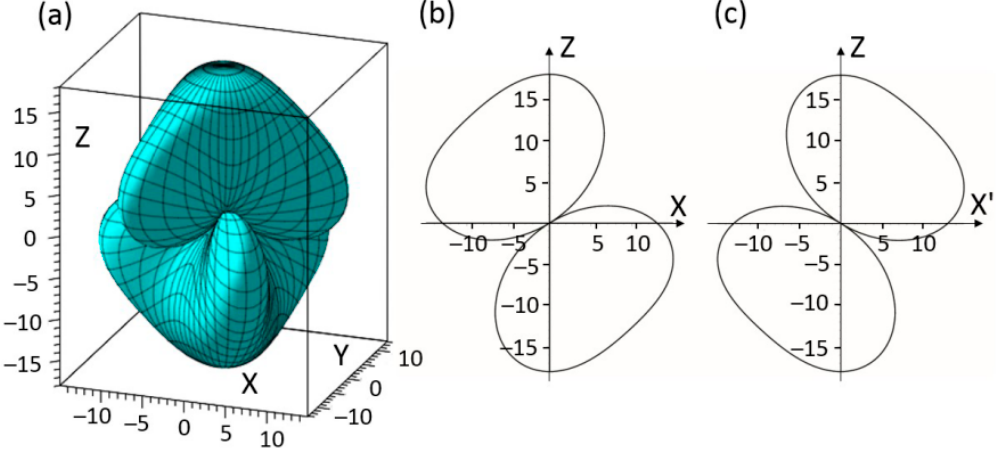
Figure 6. Schematic diagram of piezoelectric constant d 31 by the experimental data of BiFeO 3 (unit 10 − 12 C/N ).